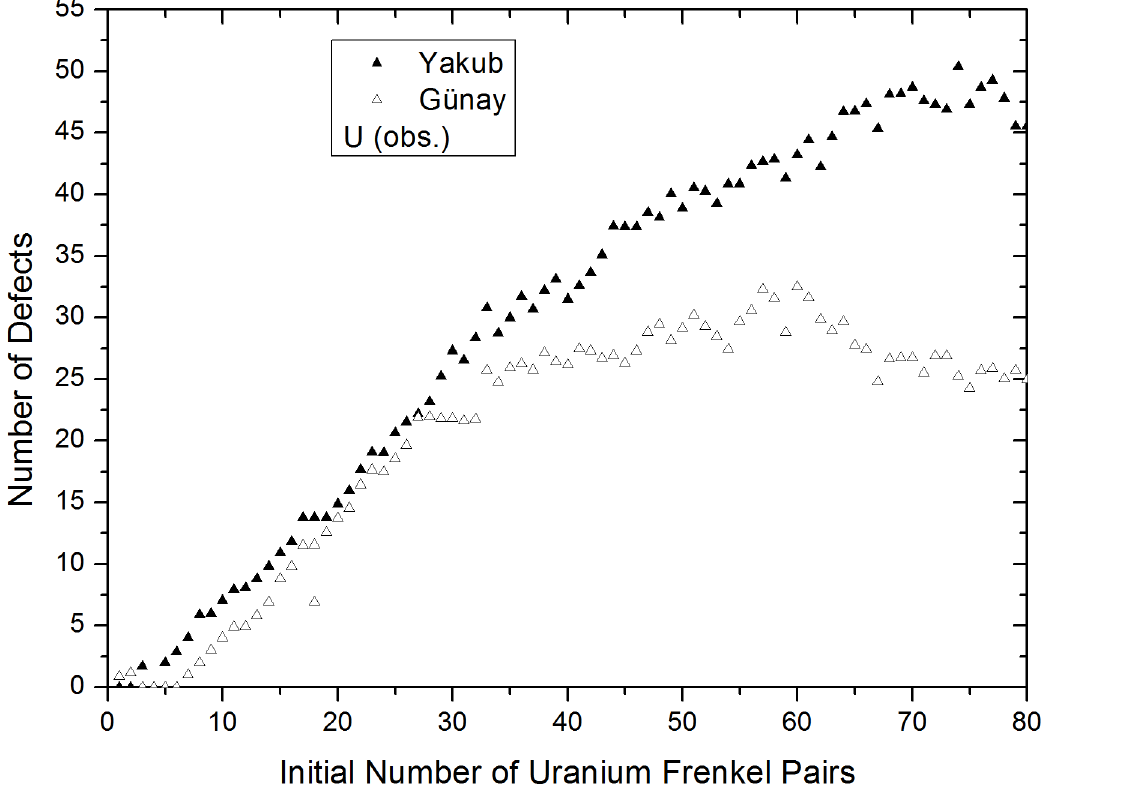
Fig 11. Number of uranium FPs versus IFPs, calculated using the Yakub and Günay